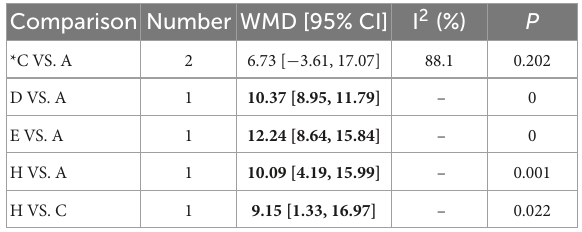
TABLE 5 Self-Rating Depression Scale (SDS) pairwise meta-analysis